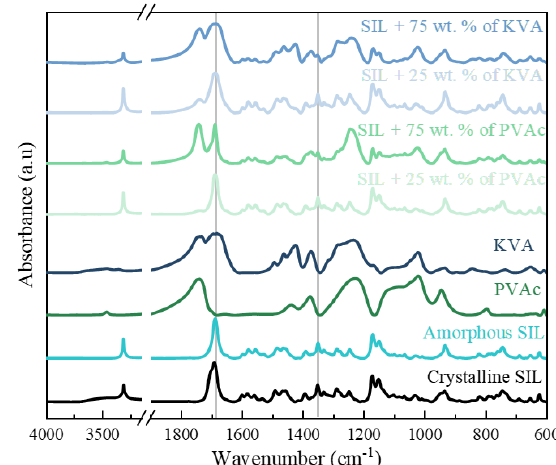
Figure 2. Experimental infrared spectra of crystalline, as well as amorphous, SIL and SIL-based amorphous solid dispersion (ASD) samples, which were prepared by melting the binary physical mixture at 468 K and then quenched. Grey lines at 1687 cm − 1 and 1349 cm − 1 correspond the to –C = O and –S = O peaks, respectively.